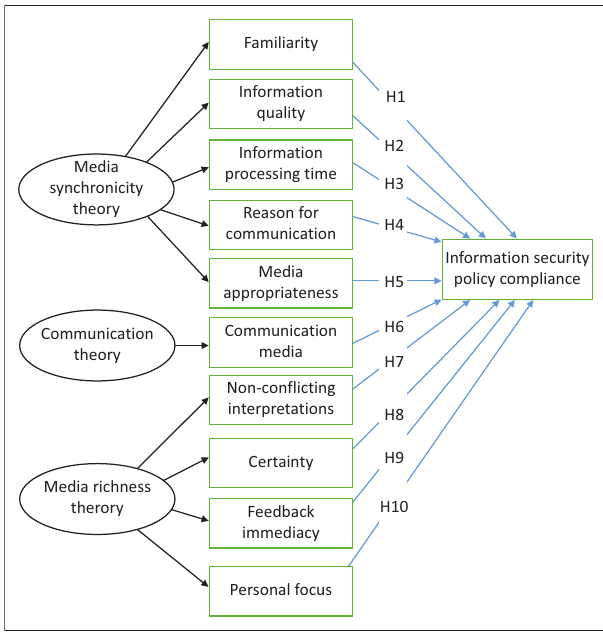
FIGURE 1: Miscellany of perception and determinism framework for communicating InfoSec policies.